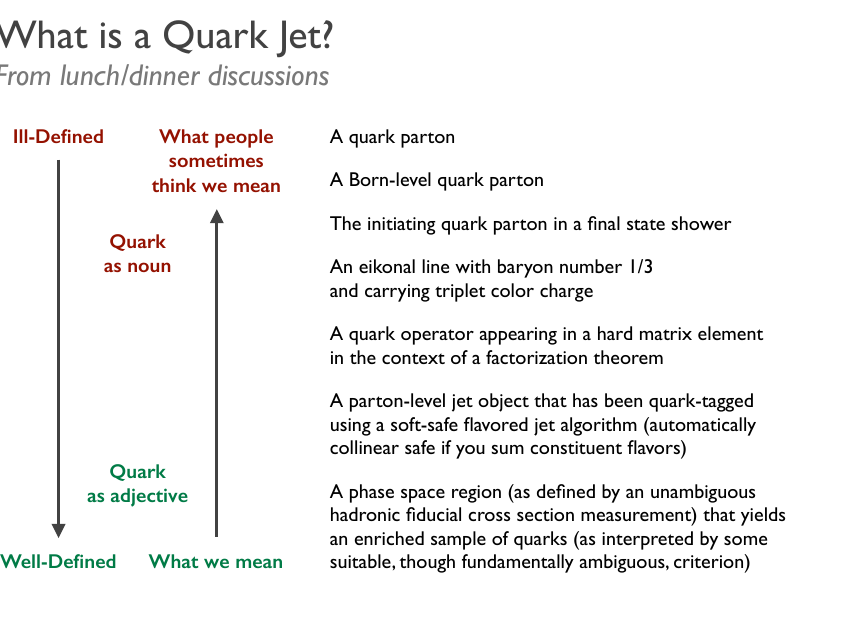
Figure 1. Original slide from the June 10, 2015 summary report of the quark/gluon Les Houches subgroup